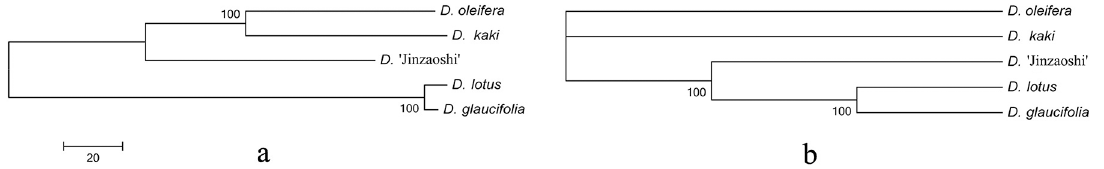
Fig 3. Phylogenetic trees based on whole genome sequences of Diospyros . (a) Maximum likelihood tree, (b) Maximum parsimony tree.